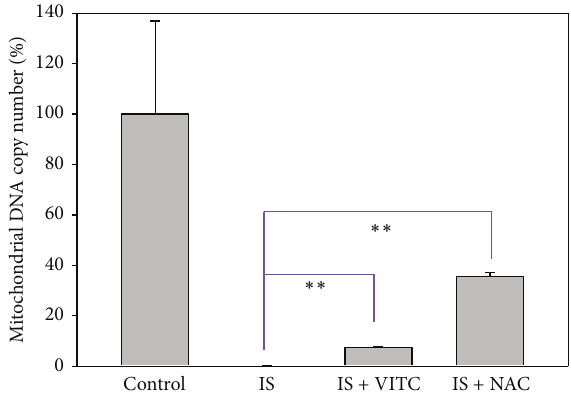
Figure 4: Role of antioxidants in IS-induced mtDNA copy number changes in HUVECs. Quantification analysis of relative mtDNA copy number (% of control) was shown. Cells were treated with IS 125 𝜇 g/mL alone as the positive control, cotreated with IS 125 𝜇 g/mL and vitamin C 200 𝜇 M or NAC 10mM for 48 h. Cells without IS treatment were regarded as the negative control. Data, mean ± SD ( 𝑛 = 2 ). ∗∗ 𝑃 < 0.005 compared to the IS only. VITC: vitamin C.